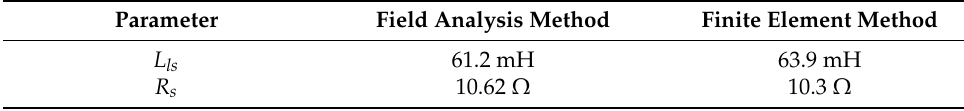
Figure 8. Thrust versus velocity curve. 4.2. Dynamic Characteristics of LIMs Based on the Proposed Model The dynamic equivalent circuit of the LIM, in the form of the space-vector model, was shown in Figure 4b. The secondary resistance R r can be computed by Equation (23). The LIM voltage equations in the arbitrary reference frame are as follows [28]: 𝑣 (cid:3046) = 𝑅 (cid:3046) 𝑖 (cid:3046) + 𝑗𝜔𝜆 (cid:3046) + 𝑝𝜆 (cid:3046) + 𝑅 (cid:3046)(cid:3035) (𝑖 (cid:3046) + 𝑖 (cid:3045) )